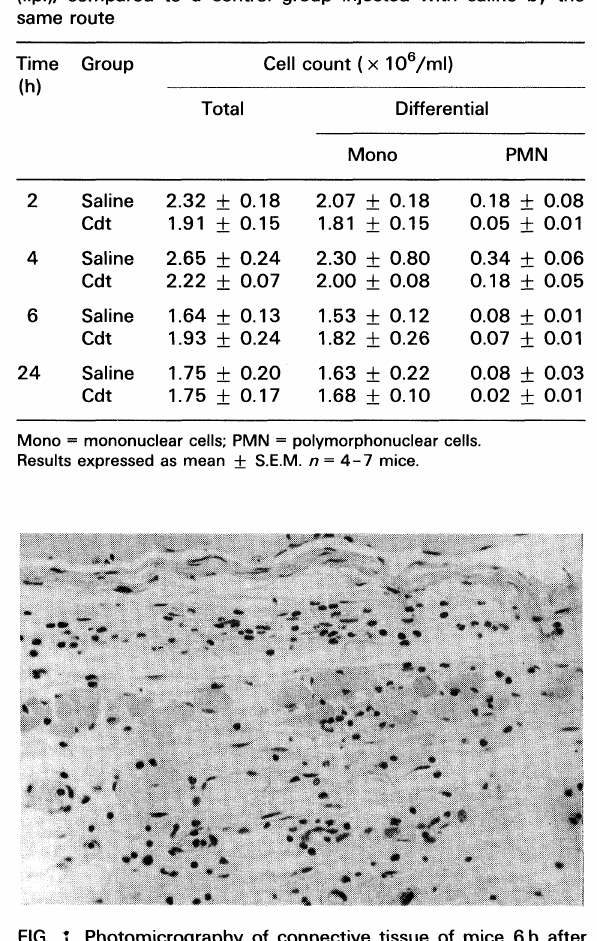
Table 1. Total and differential count of cells from the peritoneal cavity of mice injected with O.51g C.d.terrificus (Cdt) venom (i.p.), compared to a control group injected with saline by the same route Time Group